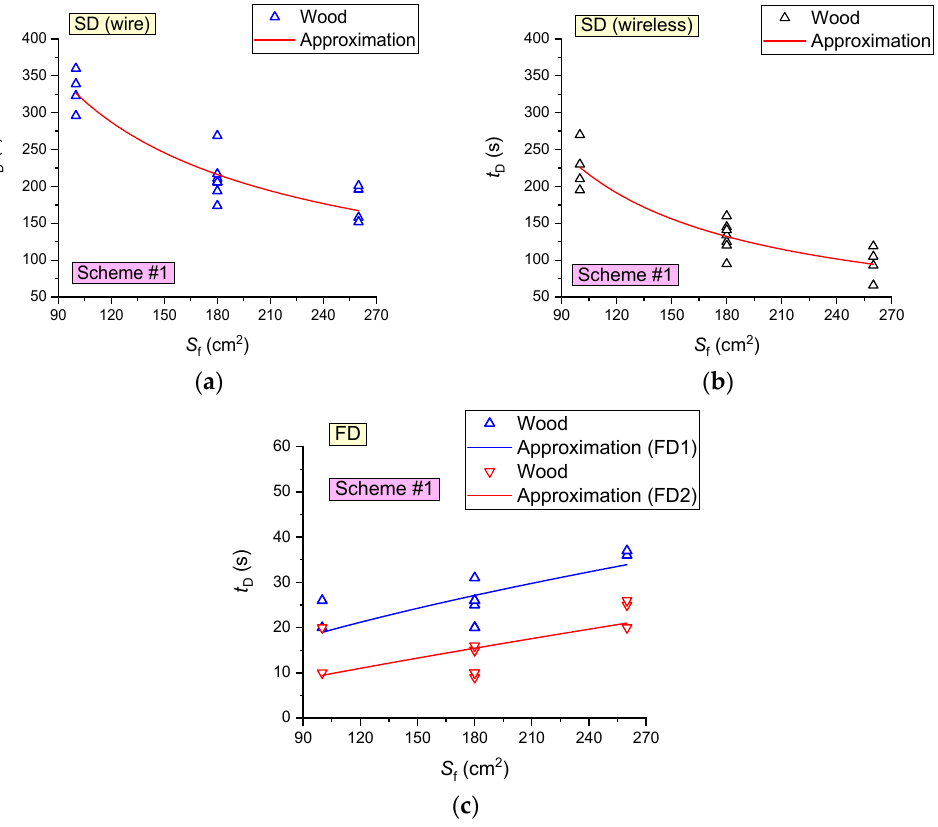
Figure 13. Fire detector (FD and SD) activation delay times versus the fire area during wood